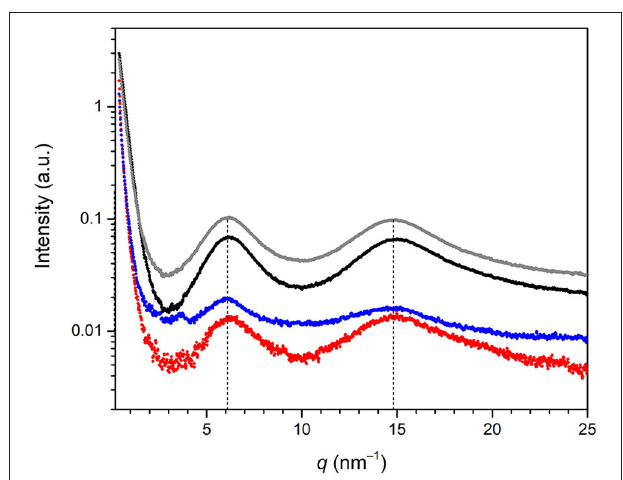
FIGURE 3 | SWAXS spectra of the BS-1 (black line), BS-2 (gray line), BS-3 (red line), and BS-4 (blue line) hybrids.